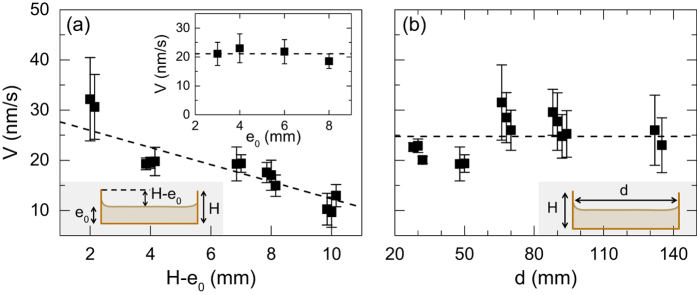
(a) Average thinning rate V of 1.5% w/w agar gels, measured at the center of the Petri dish vs. the height H − e0 of the lateral wall relative to the gel thickness, where H and e0 stand respectively for the height of the lateral wall of the Petri dish and the initial thickness of the gel (see the sketch in the lower inset). The dish height H is kept constant and the thickness of the gel is varied from e0 = 2 mm to 10 mm, such that H − e0 varies from 2 mm to 10 mm. For each value of H − e0, we perform three independent experiments on gels prepared anew. Each point corresponds to an average over 10 minutes and the error bars represent the standard deviation computed over the same duration. The dashed line is the best linear fit of the data: V = (29.3 ± 2.3) − (1.7 ± 0.3)(H − e0). Inset: average thinning rate V of 1.5% agar gels measured at the center of the dish vs. the gel initial thickness e0. The relative height of the dish with respect to the gel thickness is kept constant for all the experiments: H − e0 = 4 mm. The dashed line stands for the average value: V = 21 ± 1 nm/s. All the experiments are performed at T = (25.0 ± 0.5) °C in a plastic Petri dish made of PS (H = 12 mm), except for the experiments at H − e0 = 7 mm reported in the main graph, which are performed in a dish made of glass (H = 11 mm). (b) Average thinning rate V of 1.5% agar gels measured at the center of the dish and averaged over 10 minutes vs. the dish diameter d. The relative height of the lateral wall compared to the gel thickness is kept constant H − e0 = 7 mm for all the experiments. For each value of the dish diameter d, we perform two to four independent experiments on gels prepared anew. Error bars correspond to the standard deviation of the thinning rate over 10 minutes. The horizontal dashed line stands for the average value: 〈V〉 = 24.7 nm/s. Experiments conducted at T = (25.0 ± 0.5) °C in Petri dishes made of glass.